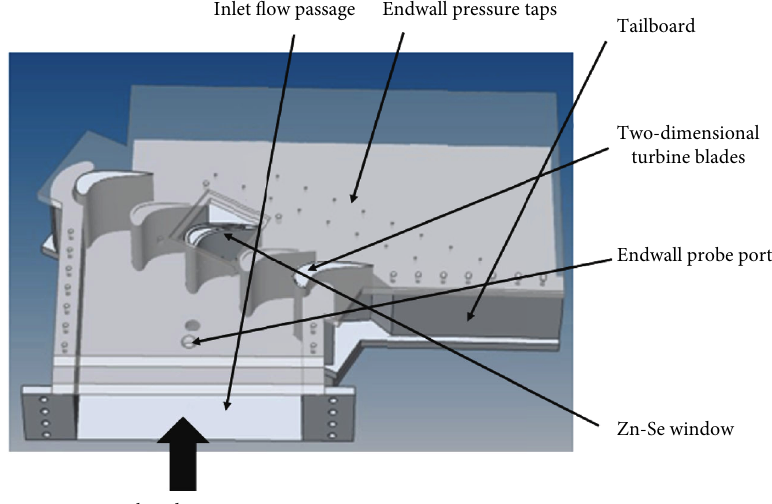
Figure 1: Schematic of linear